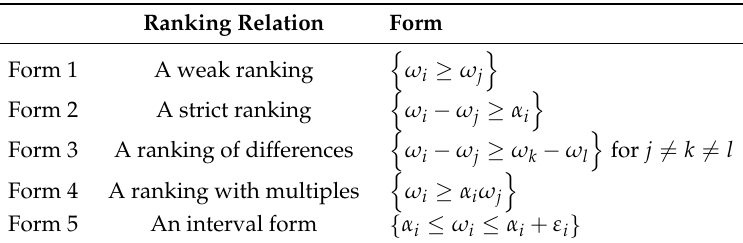
Table 1. The different types of attribute